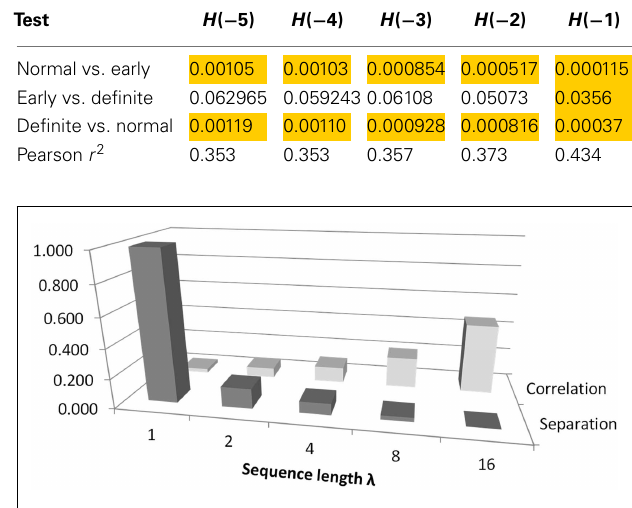
FIGURE 8 |An illustration of the trade-off between correlation and separation for choosing sequence length λ when using the density method of estimating probabilities for calculating Renyi entropy .The figure relates to methods 5–9 as defined in the Section “Introduction.”The vertical axis shows Pearson’s r 2 for correlation. For separation, the vertical axis is scaled for convenience, so that 1.0 corresponds to a p- value of 0.1.